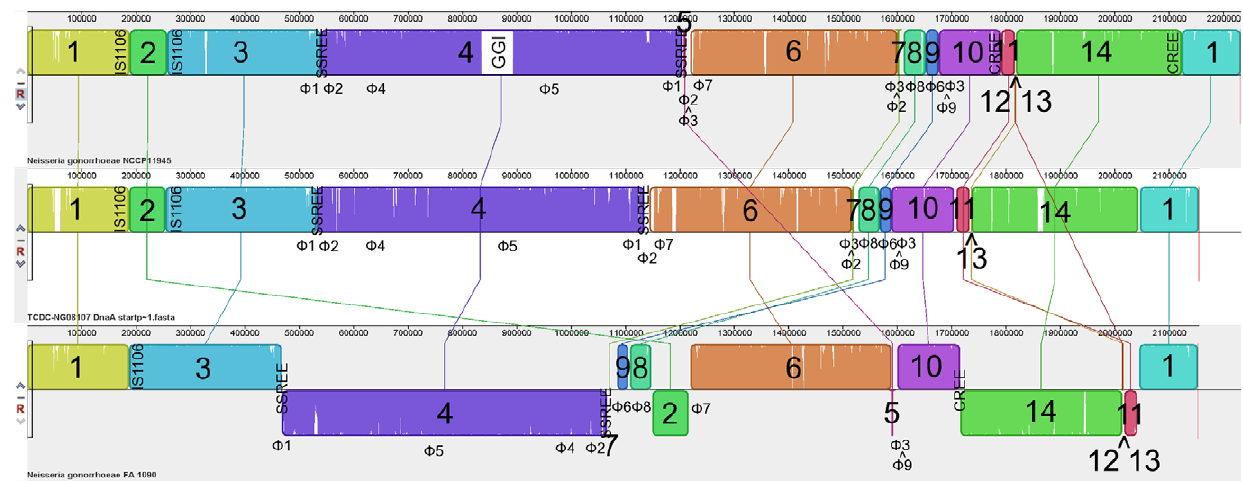
Figure 1. Three-way Mauve alignment of N.gonorrhoeae strains NCCP11945 (top), TCDC-NG08107 (middle), and FA1090 (bottom). The numbered blocks represent regions of homology between strains as determined by progressive Mauve alignment on default settings. White vertical lines within blocks represent small localized areas of the genome sequences that have not aligned. The largest of these is the Gonococcal Genetic Island (GGI), which is present in strain NCCP11945 but not the other two strains. Blocks below the central line represent sequences that are inverted in comparison to the strain NCCP11945 arrangement. Homologous blocks are numbered 1 to 14. Blocks 5 and 12 are absent from TCDC- NG08107. Positions of prophage sequences, some of which are fragmented, are indicted: NGO F 1 ( F 1); NGO F 2 ( F 2); NGO F 3 ( F 3); NGO F 4 ( F 4); NGO F 5 ( F 5); NGO F 6 ( F 6); NGO F 7 ( F 7); NGO F 8 ( F 8); and NGO F 9 ( F 9). Labeled are the positions of block 2 flanking IS1106 elements, the block 4 flanking SSREE elements, and the block 11–14 flanking CREE in strain NCCP11945. Note that the chromosomal positions for strain TCDC-NG08107 do not equate to those in GenBank; position 1 was adjusted to be the first base of dnaA to facilitate comparisons.